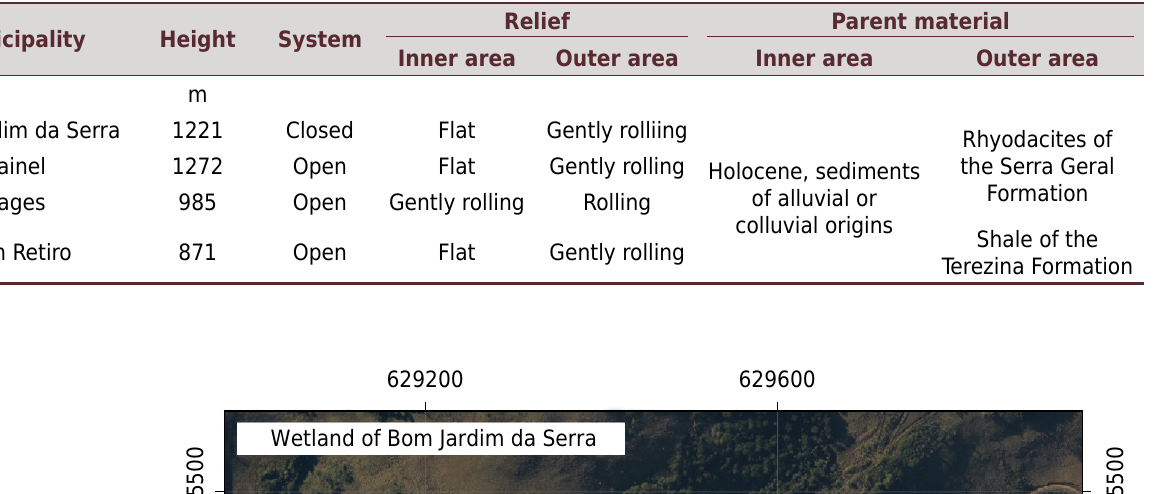
Table 1. Identification and characteristics of the wetland areas evaluated in the field